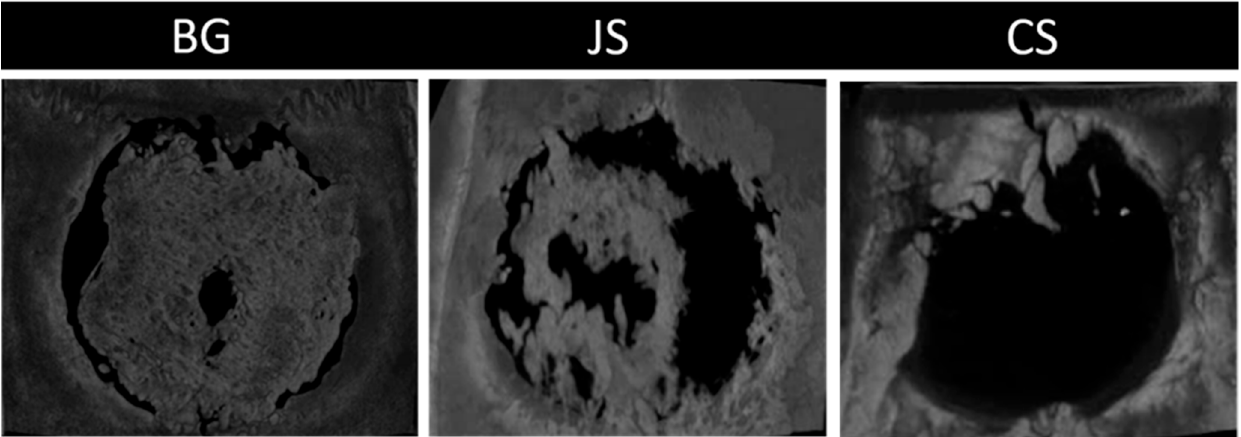
Figure 10. Axial reconstruction of the critical calvaria defect after 60 days of bone repair for the BG, JS, and CS groups. Note that the largest area of bone neoformation was for the BG group, followed by the JS and CS groups.